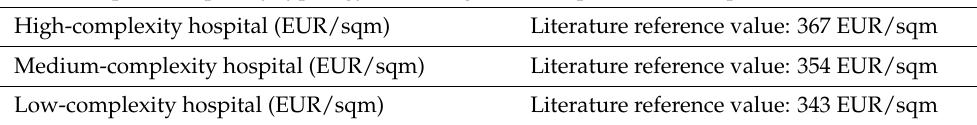
Table A5. Technological units’ cost. In this section, it is required to insert a value in EUR/sqm for the technological units by the hospital complexity typology, according to own experience in hospital construction